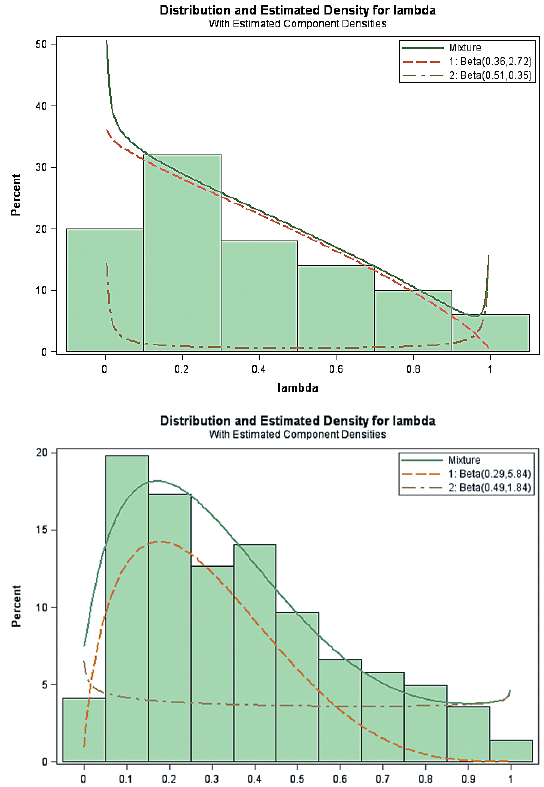
Fig. 5. Finite beta mixture descriptions of eigenvalues: two components Left (a): n = 50. Right (b): n = 204. Bottom (c): n =